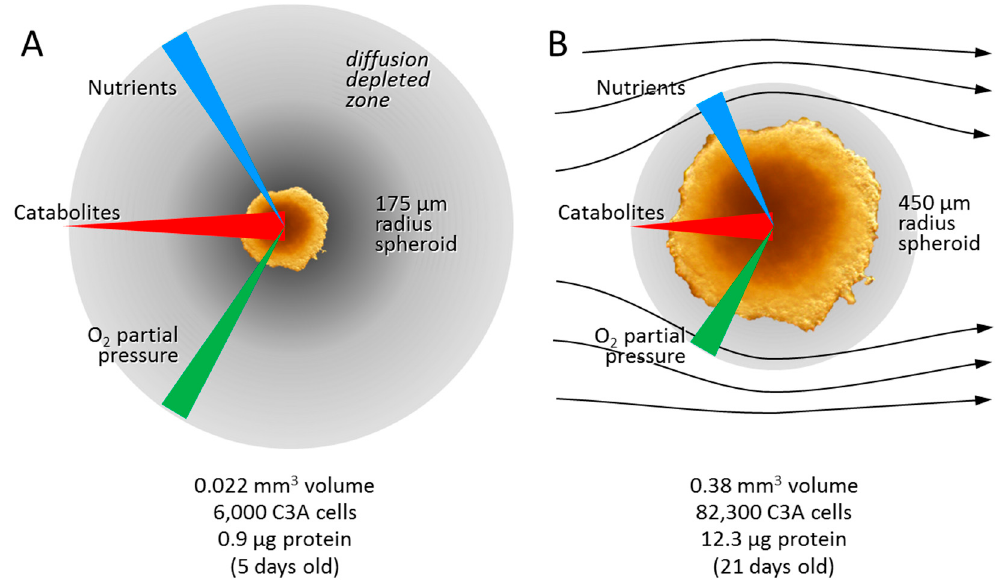
Figure 3. The diffusion depleted zone and its consequences for the oxygen, nutrient and catabolite gradients in ( A ) passive and ( B ) irrigated 3D culture. The size shown indicates the approximate maximum size above which anoxia develops in the spheroid core. Volumes, number of cells and amounts of protein are indicated for each. The apparent increase in cell volume is attributed in part to increased ECM and the development of sinusoidal and bile cannalicular spaces between the cells.